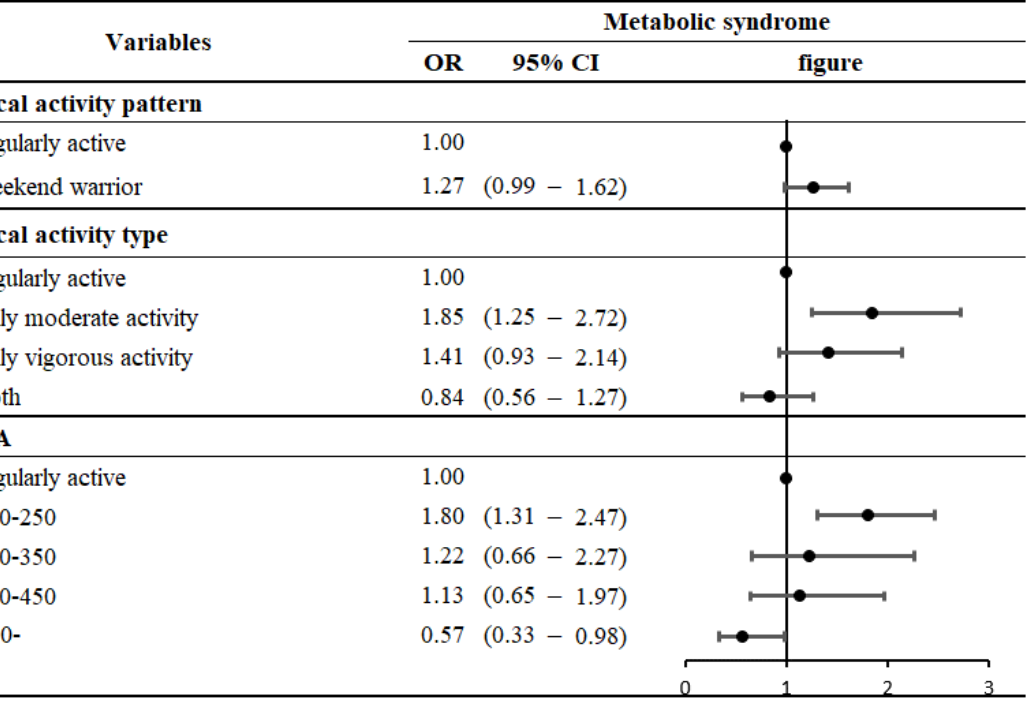
Figure 2. Association of weekend warrior physical activity pattern with metabolic syndrome, with regularly active participants as the reference category.